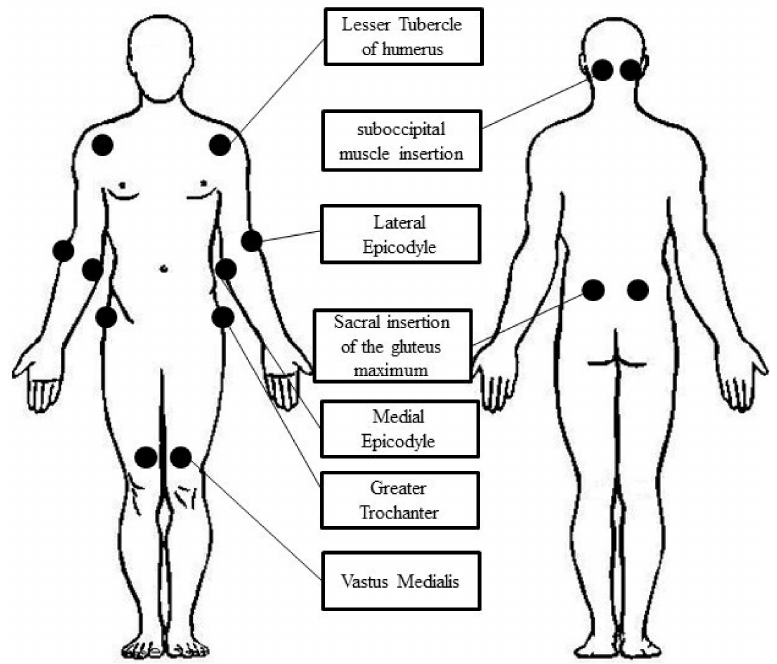
Figure 1. Graphical Representation of the point evaluated for the assessment of